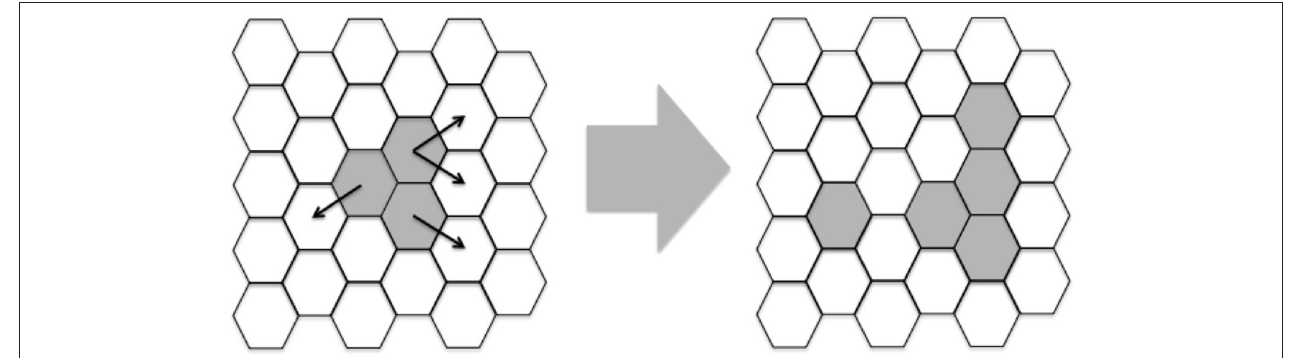
FIGURE 2 | Example of two iterations of a portion of the lattice. White hexagons represent epithelial cells and gray area hexagons shared by Leishmania and epithelial cells. Besides these two agents, macrophages, DC and naïve T-cells are assumed to be present everywhere. Notice that the lattice is initialized with three adjacent hexagons containing Leishmania and these hexagons propagate randomly modeled by Equations (1) and (9). In latter iterations other players like Th1/2 cells will also be generated.